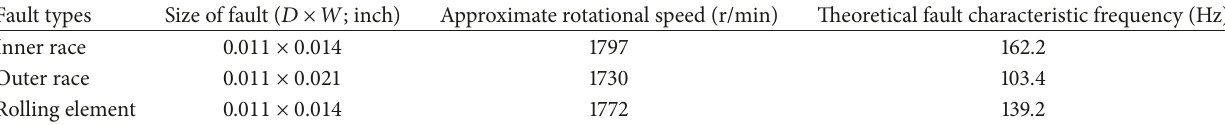
Table 2: Acquisition information of the rolling bearing from the bearing data center of CWRU.